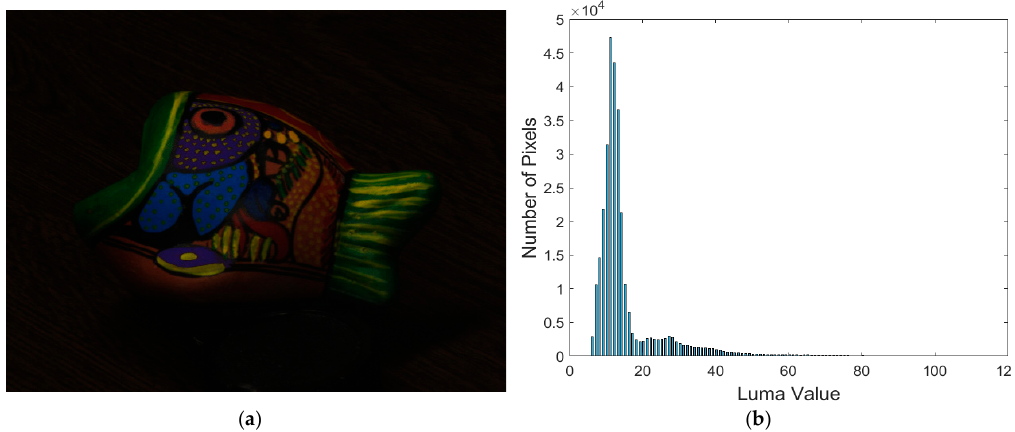
Figure 4. ( a ) HF image after removing mismatch; and ( b ) histogram of luminance of ( a ).